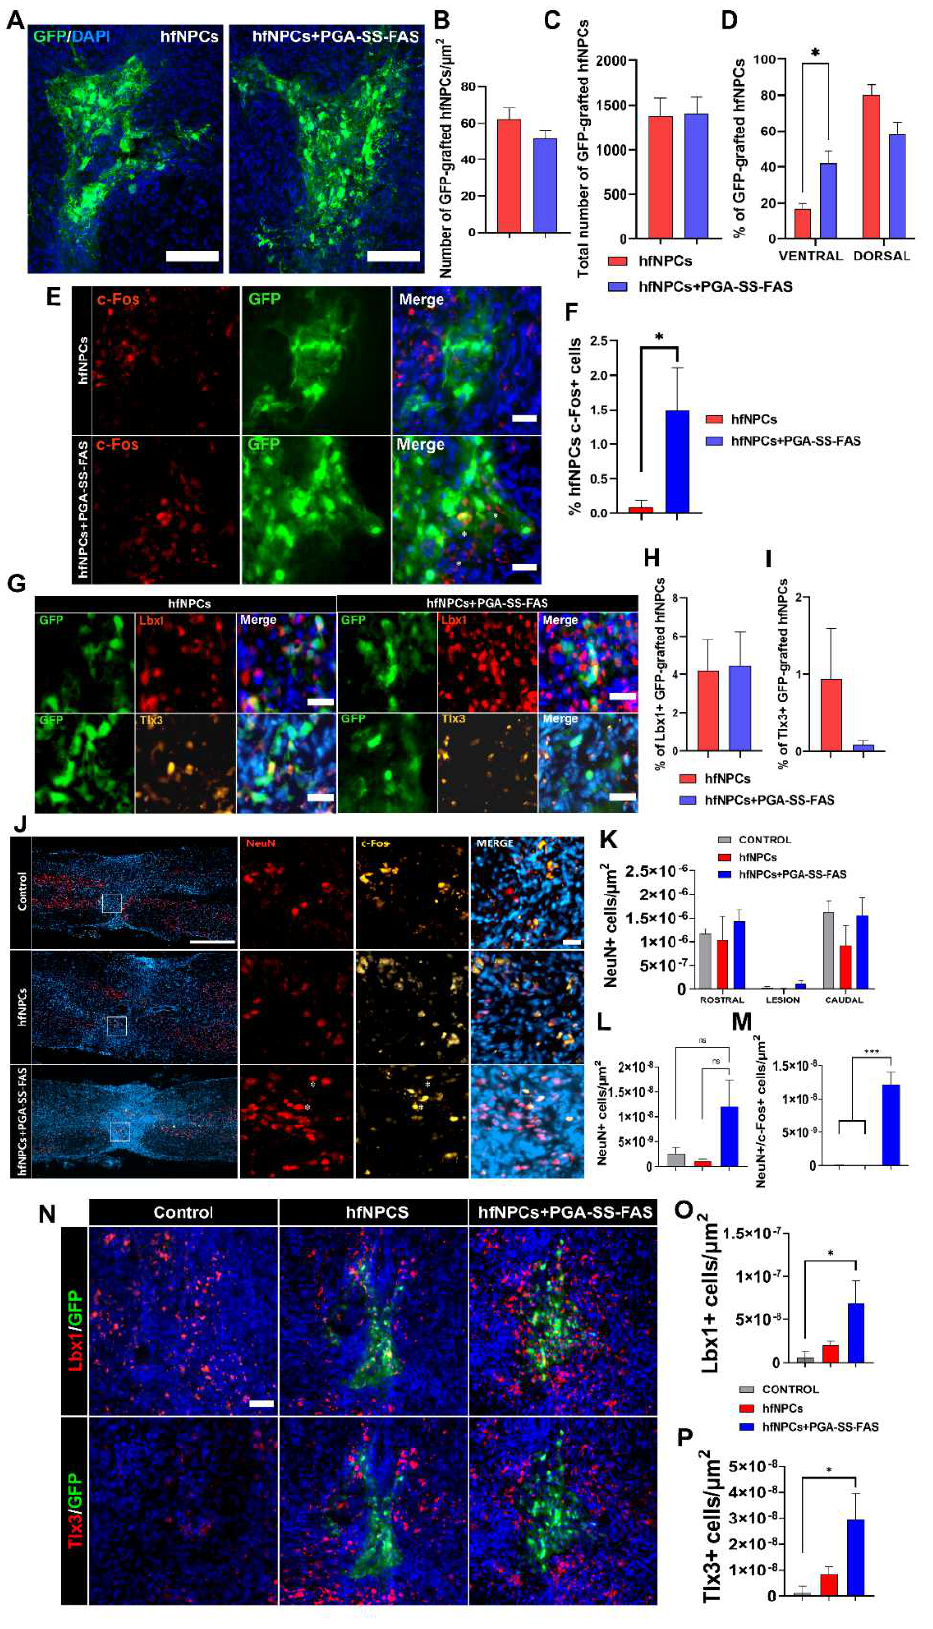
Figure 4. Quantification, distribution, and phenotypic characterization of non-primed and primed hfNPCs post-transplantation. ( A ) Representative images of GFP staining for hfNPC-grafted cells in